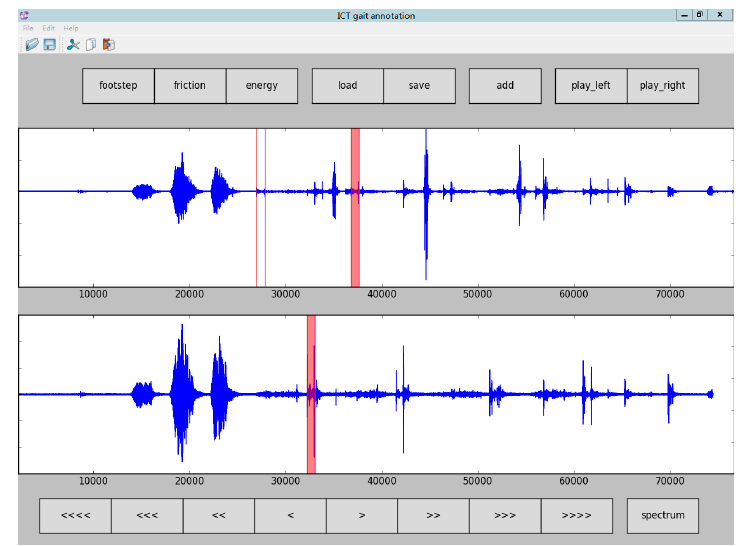
Figure 9. Screenshot of the temporal parameter label tool.